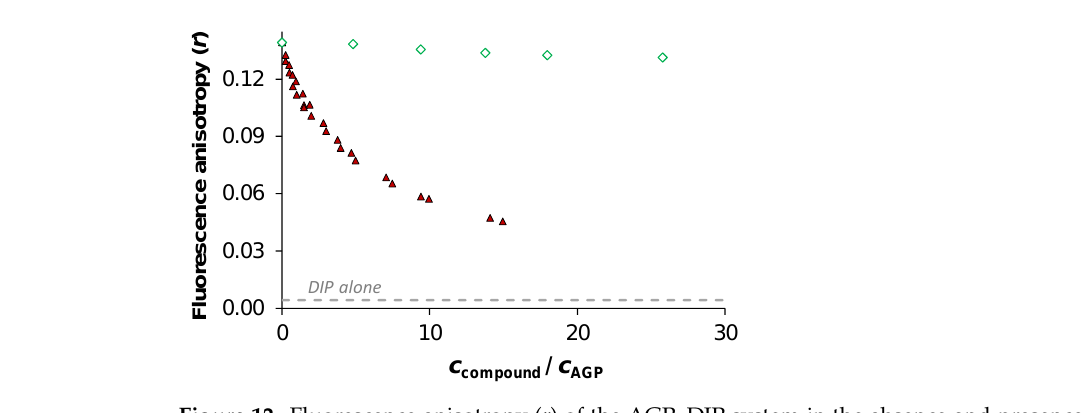
Figure 12. Fluorescence anisotropy ( r ) of the AGP–DIP system in the absence and presence of IMA ( ▲ ) or h-MOLNU ( ♦ ); anisotropy signal of free DIP (grey dashed line, r = 3.0 × 10 − 3 ± 8 × 10 − 4 ) is indicated as well [ c AGP = 2.0 μM; c DIP = 1.0 μM; λ EX = 400 nm; λ EM = 500 nm; pH = 7.4 (PBS), t = 25 °C].